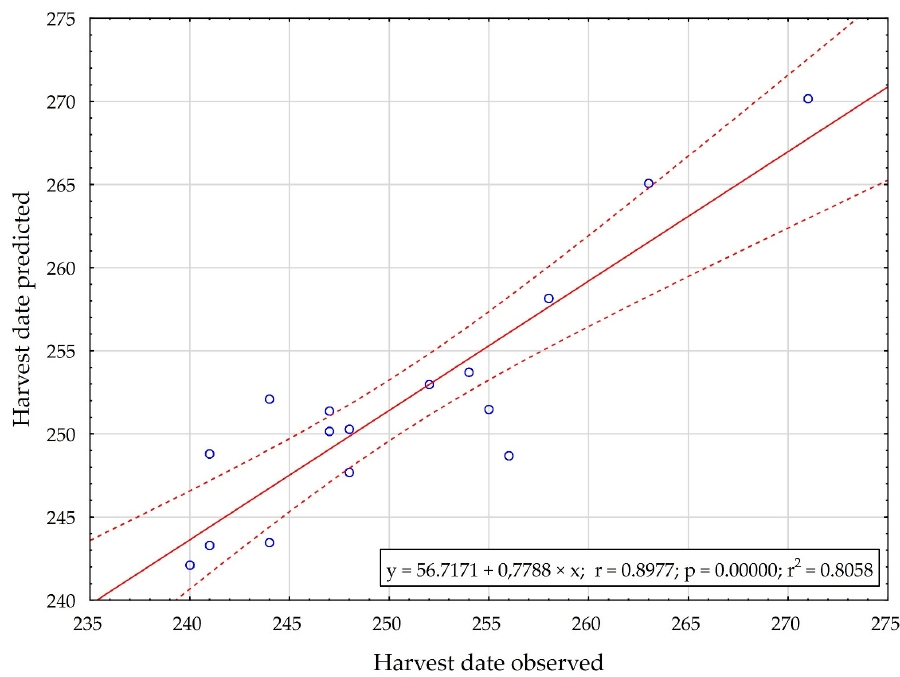
Figure 5. The scatter plot between the observed and predicted values of the soybean harvest date in model M_HARV.